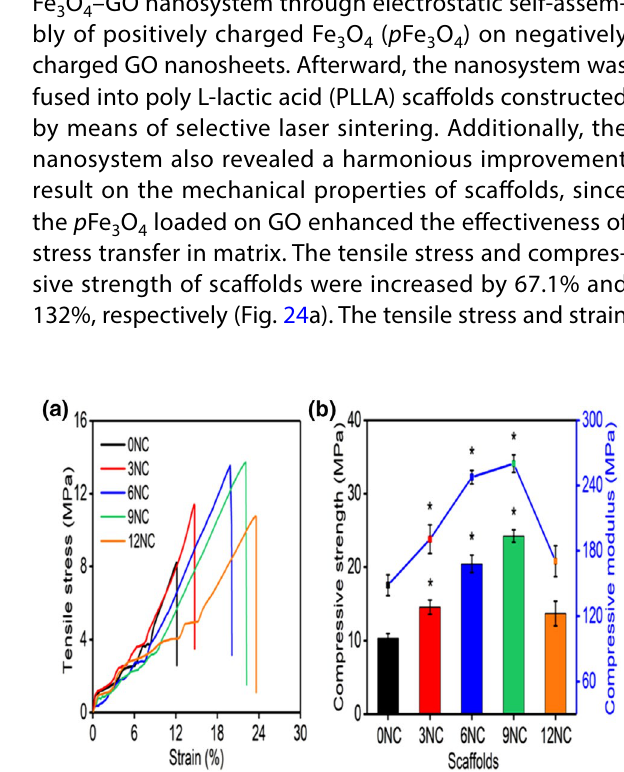
Fig. 22 Mechanical behavior of a single splat [123, 124]